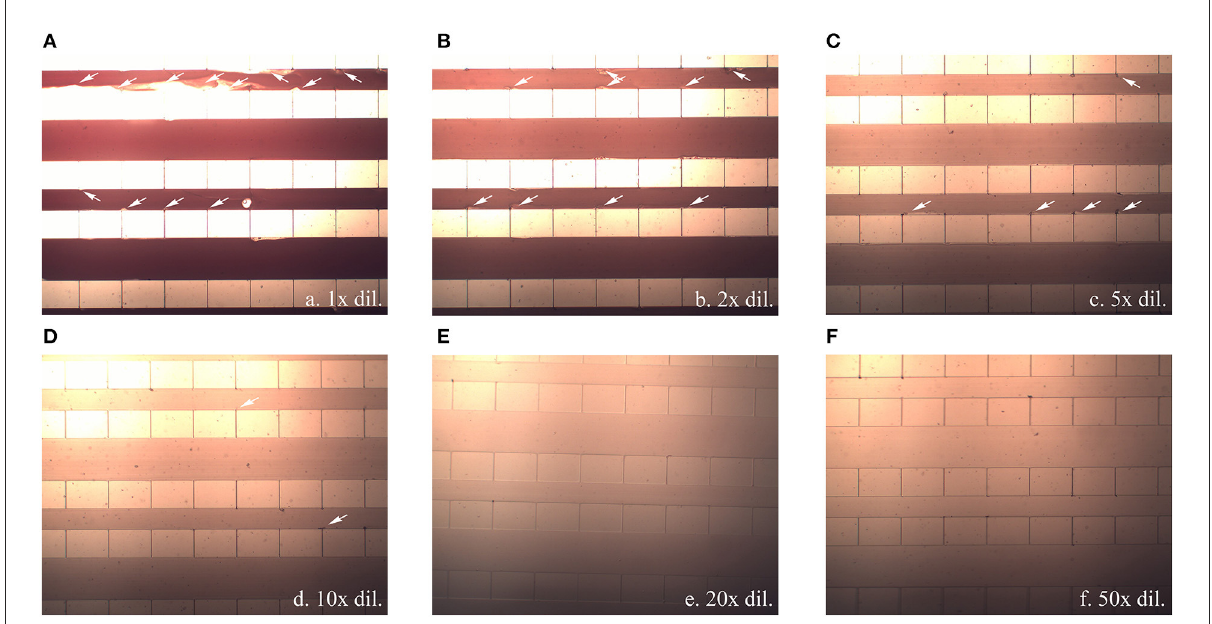
FIGURE5 Blood clogging observed inside the flow passage channel (white arrow) when a blood sample diluted at (A) 1x, (B) 2x, (C) 5x, (D) 10x, (E) 20x, and (F) 50x was injected at 1 mL/min. All pictures were captured using 20x magnification.